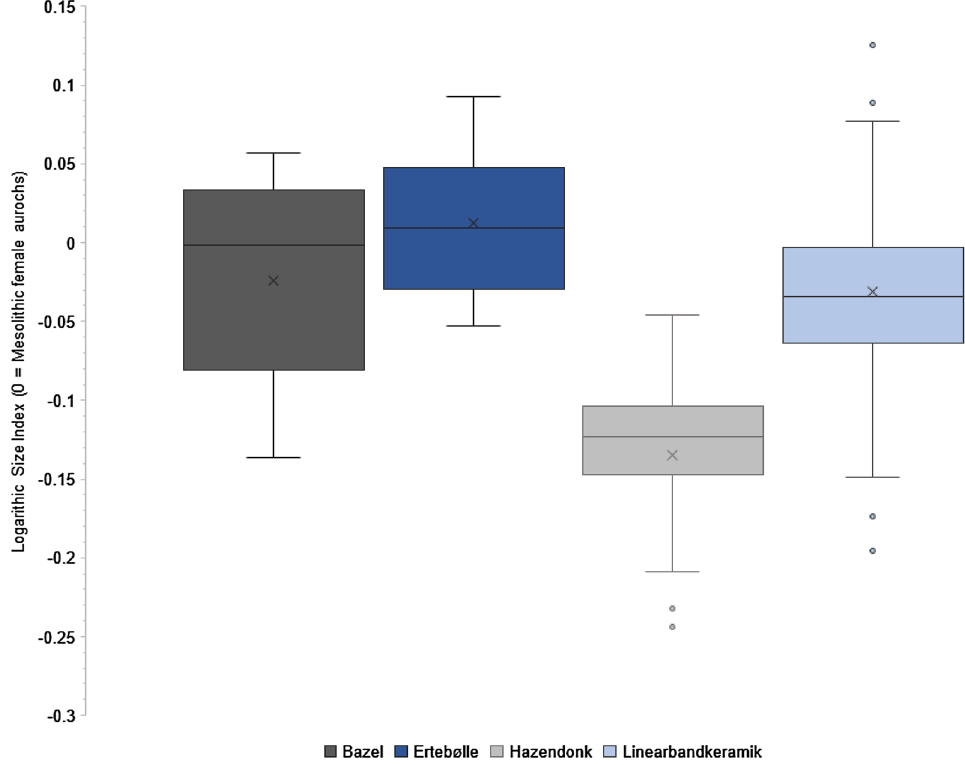
Figure 1. Boxplot showing the Logarithmic Size Indices of Bos breadth dimensions from the site Bazel Sluis 1,2 , available Ertebølle culture sites 13 , the Hazendonk culture site of Schipluiden, the Netherlands 13 , and available Linearbandkeramik culture sites 13 (x =